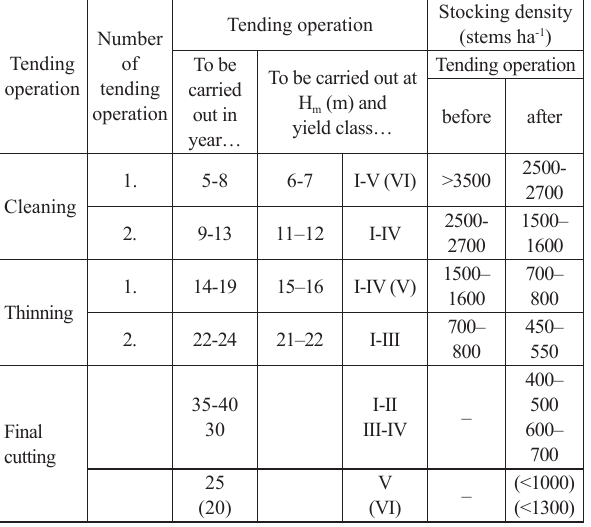
Tabla 1: Simplified tending operation model for black locust